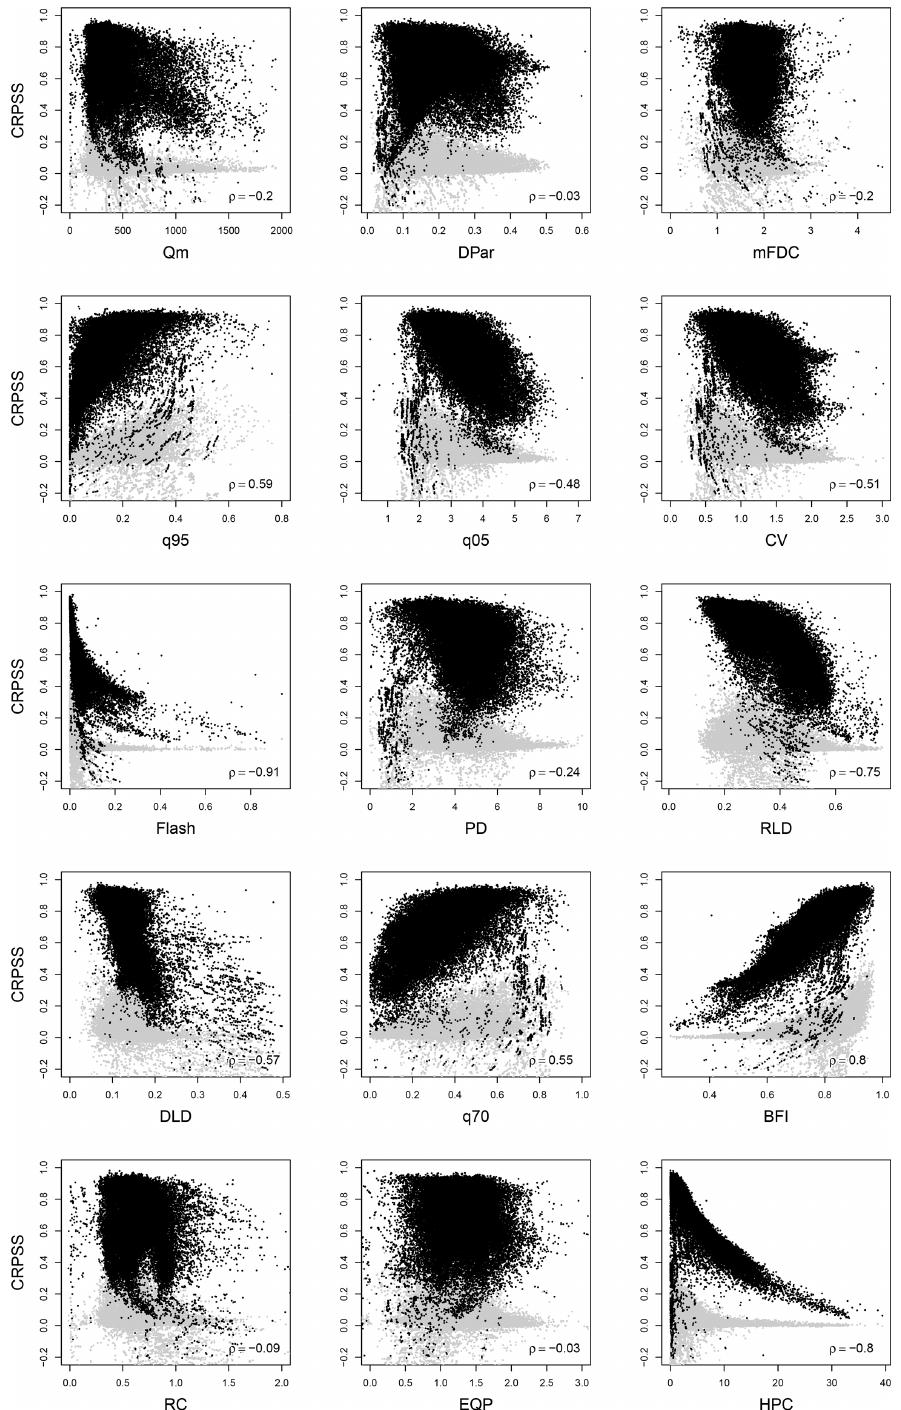
Figure 6. Forecast skill (in terms of CRPSS) for lead week 0 (black dots) and lead week 8 (light grey dots) for each of the 39493 catchments in Sweden as a function of each of the 15 hydrological signatures. The non-parametric Spearman’s rank correlation coefficient for lead week 0 ( ρ ) is shown for each